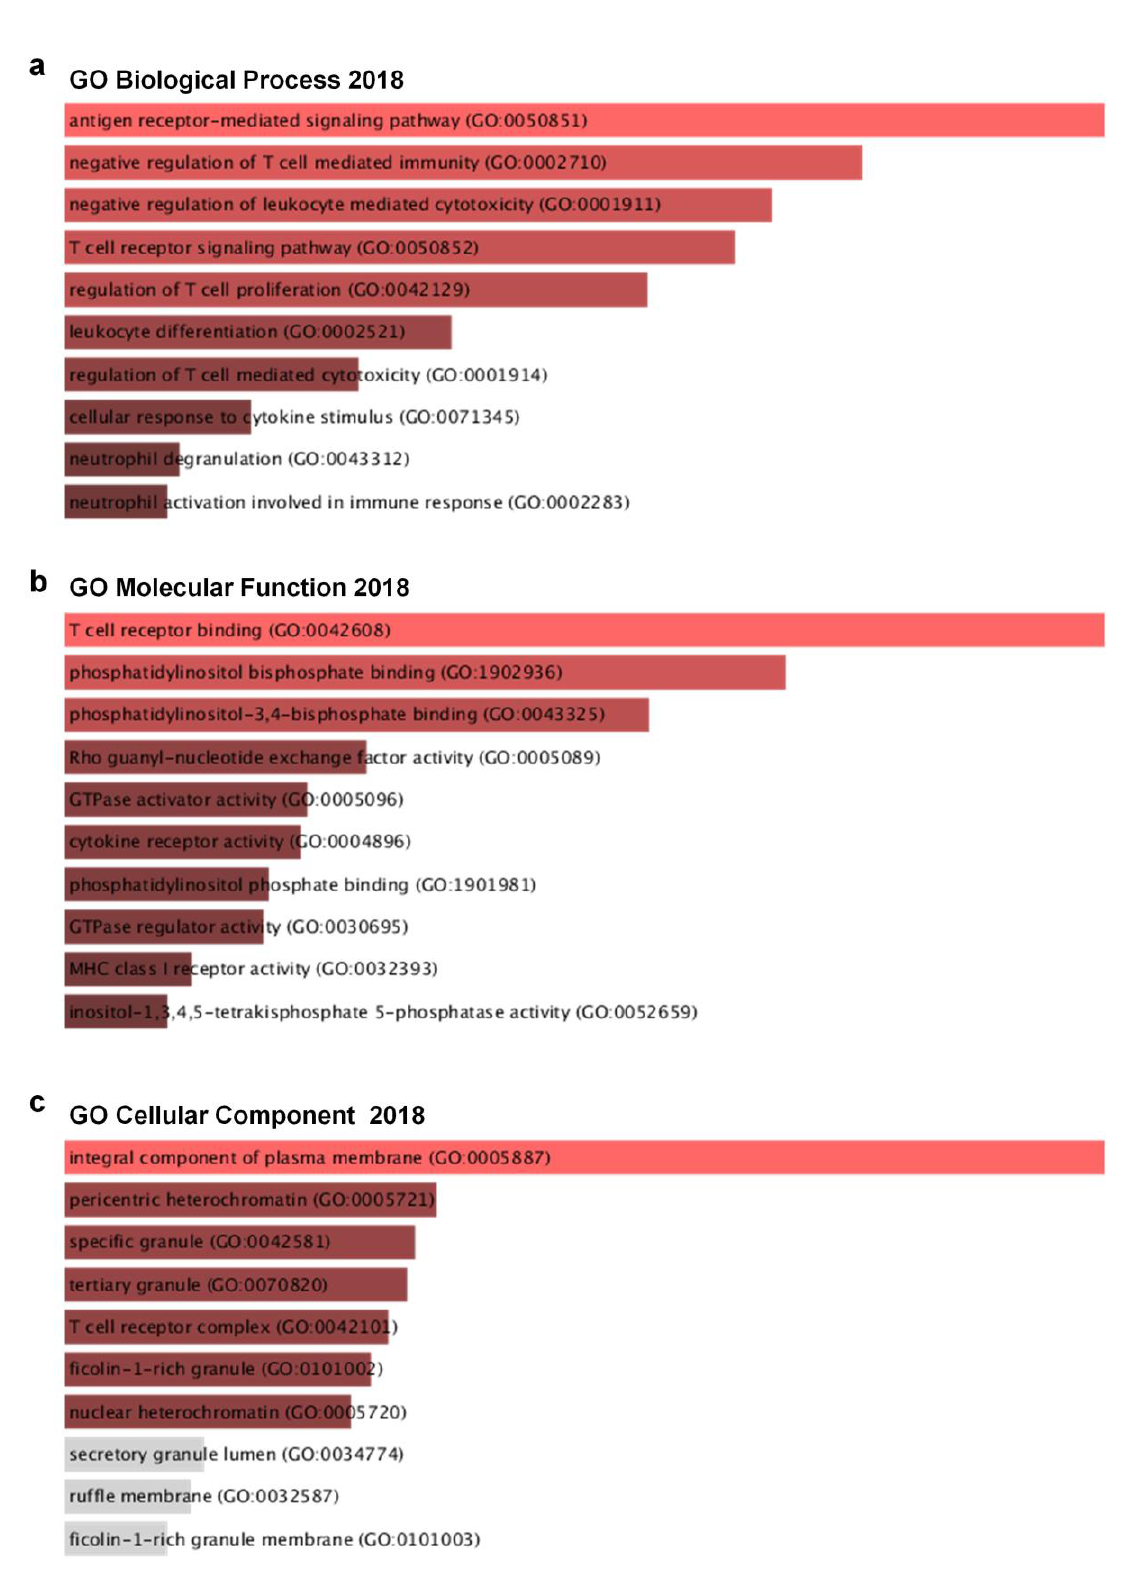
Figure 7. Ly75 gene and its co-expressed genes are involved in signaling pathways in SKCM: Gene ontology analysis were carried out with Ly75 gene and its top 25 co-expressed genes with the Enricher web tool (https: // amp.pharm.mssm.edu / Enrichr). ( a ) Enrichment of GO Biological Process (2018), ( b ) Enrichment of GO Molecular Function (2018), and ( c ) Enrichment of GO Cellular Component